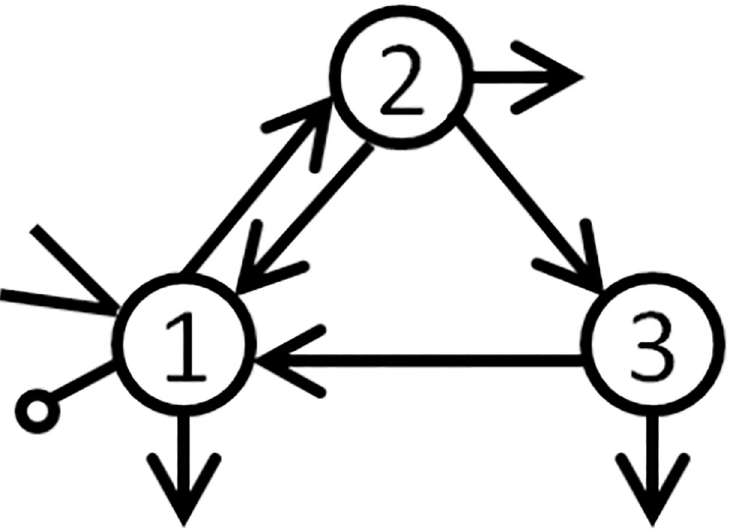
Fig 1. A 3-compartment model. A 3-compartment model with input (represented by the arrowhead) and output (represented by the line segment with a circle at the end) in the first compartment and “leaks” from every compartment (represented by arrows leaving the compartments). Here, the input could represent a drug injection and the first compartment could represent blood, with the other two compartments representing organs, e.g., tissue and stomach. The unknown parameters represent rates of transfer from one compartment to another (drawn as arrows in the figure), or in the case of leaks, from one compartment to outside the system. The state variables represent drug concentration in the blood and organs, with output from the first compartment representing measured drug concentration in the